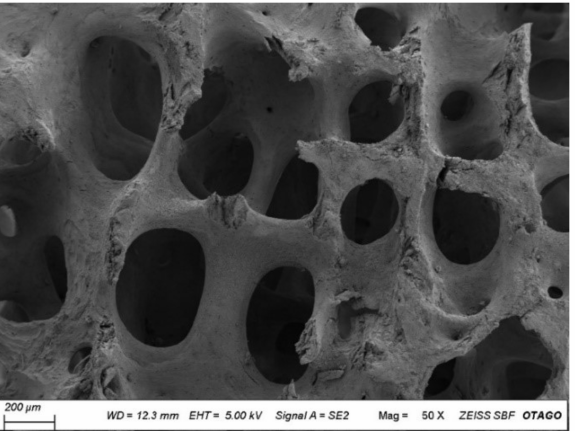
Figure 6. Representative scanning electron micrograph (SEM) of CBHA. Scale Bar = 200 µ m.